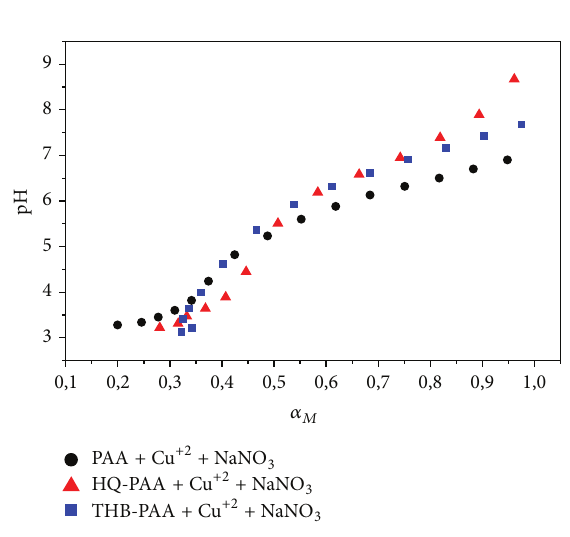
Figure 5: Plots of pH = f (𝛼 𝑀 ) for PAA/Cu(II) and HQ- PAA/Cu(II). [NaNO 3 ] = 0.00 mol/L. The curve in blue square is for tetrahydroxybenzene-polyacrylic acid (THB-PAA) in the presence of copper (II) [5].